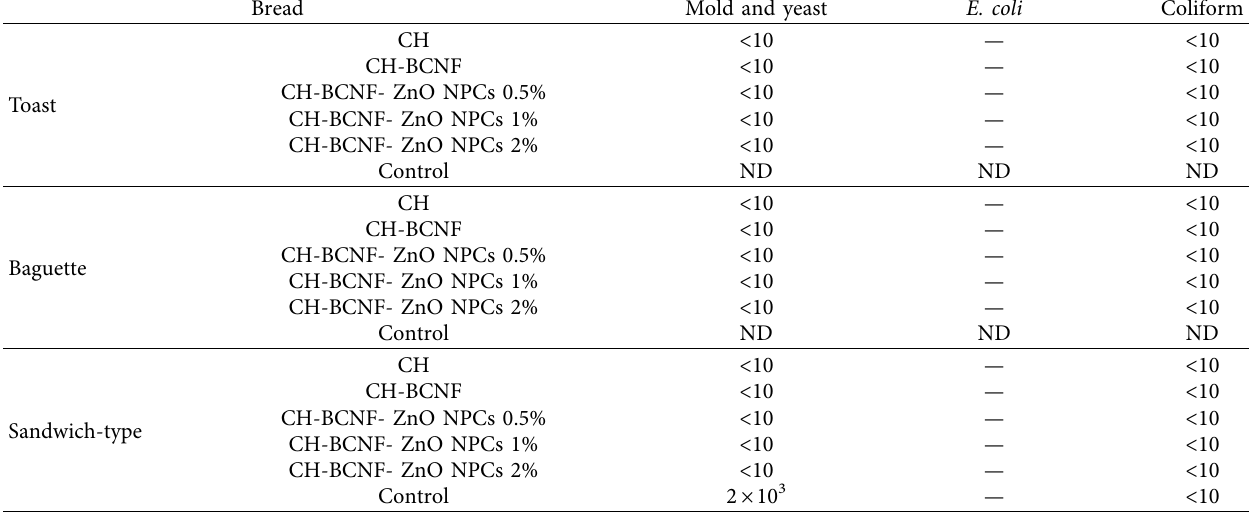
Table 5: Microbial properties of the diferent breads stored at 25 ° C. Bread Mold and yeast E. coli